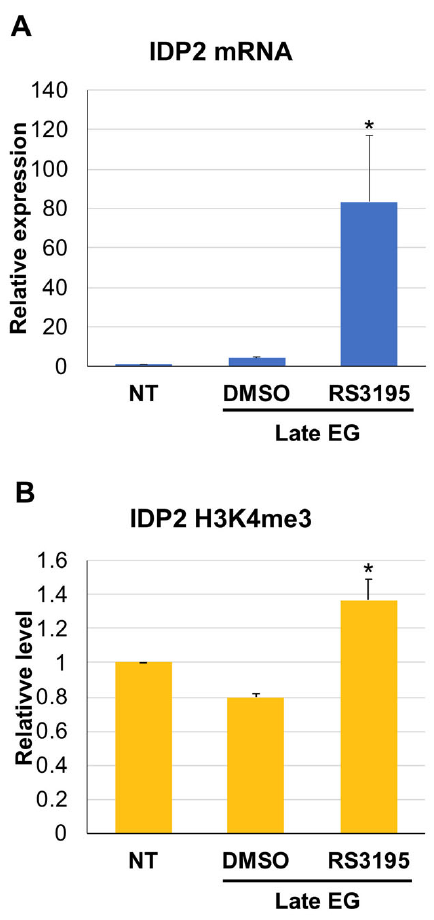
Figure 5. ( A ) Real time RT-PCR quantitation of IDP2 cDNA 2 h after addition of 15 µM RS3195 or the solvent 1% DMSO. The histogram reports the expression level normalized to the endogenous calibrator ( ACT1 mRNA) and to the untreated sample ( ΔΔ Ct). Data are the average of three independent experiments. Late EG = 0.8–1 OD 600. ( B ) Real time quanti fi cation of ChIP experiments determining the level of H3K4 trimethylation of IDP2 proximal ORF portion in the presence of the Jhd2 inhibitor RS3195. The histogram represents the H3K4me3 level of IDP2 in the presence of 15 µM RS3195 or 1% DMSO, normalized to the endogenous calibrator ( ZRT1 ORF) and to the untreated sample ( ΔΔ Ct). Data are the average of three independent experiments. Standard deviation is indicated. * = p < 0.05 according to Student’s t -test, two sided, in comparison to